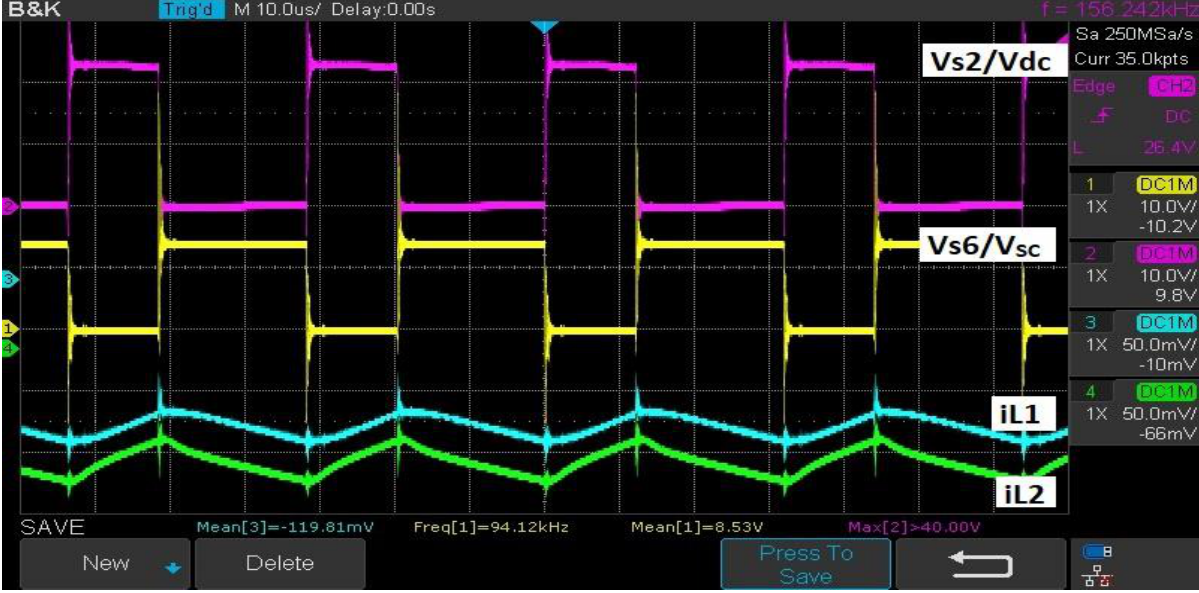
Figure 21. Simultaneously charging the DC link from the battery and supercapacitor.